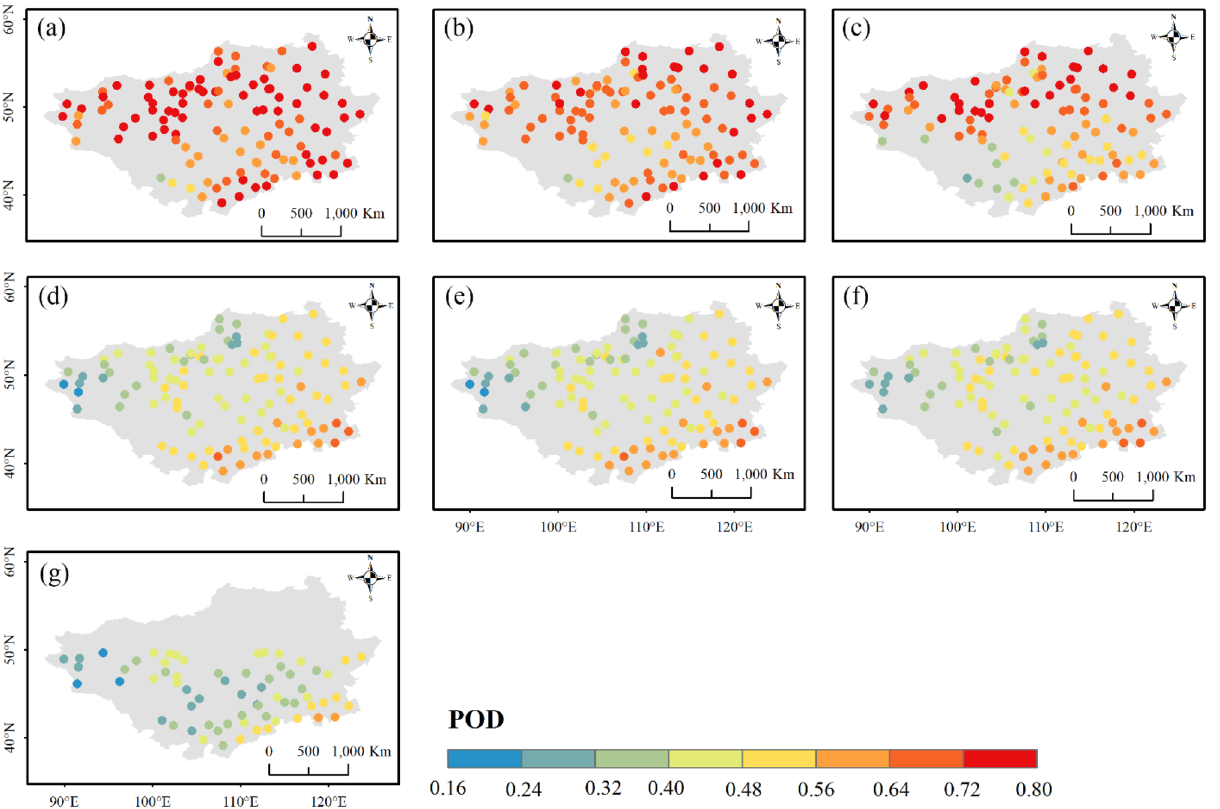
Figure 12. Spatial distribution of POD for ( a ) ERA5-Land, ( b ) ERA5-HRES, ( c ) ERA-Interim, ( d ) IMERG ER, ( e ) IMERG LR, ( f ) IMERG FR, and ( g ) TMPA-3B42. For subplot ( g ), only stations within the spatial coverage of TMPA-3B42 (50° N–50° S) were plotted. The figure was created using ArcGIS 10.7 (https:// www. esri. com/ en- us/ arcgis/ about- arcgis/ overv iew) 70